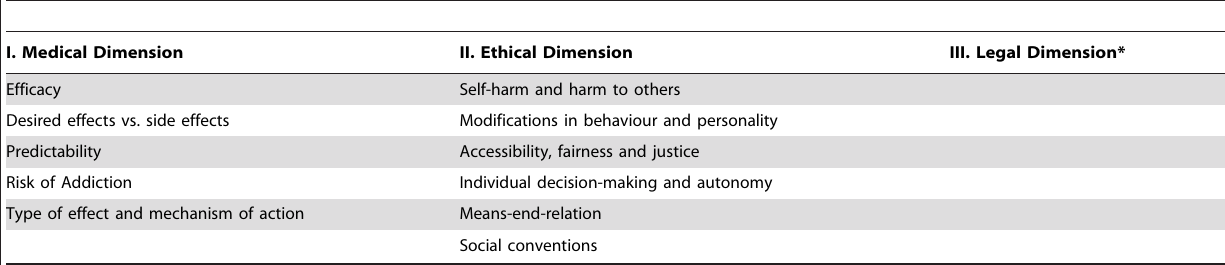
Table 2. Dimensions of arguments and fitting subcategories for the use of illicit/prescription stimulants or caffeine for CE.